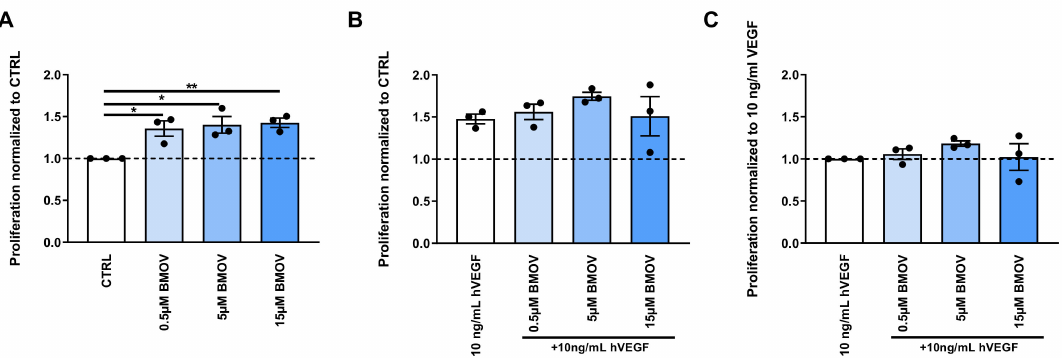
Figure 5. Quantification of HUVECs proliferation after treatment with either ( A ) BMOV alone in di ff erent concentrations (0.5, 5, 15 µ M) or ( B ) di ff erent concentrations of BMOV (0.5, 5, 15 µ M) supplemented with 10 ng / mL VEGF-A. ( C ) E ff ect of BMOV in the cell culture supplemented with 10 ng / mL VEGF-A. Datapoints represent averages obtained from 3 independent experiments and are presented as mean ± SEM. * p < 0.05; ** p < 0.01 by One-Way